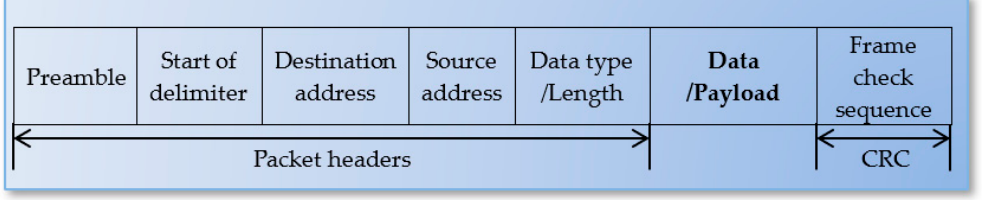
Figure 2. A typical frame of communication data packets.